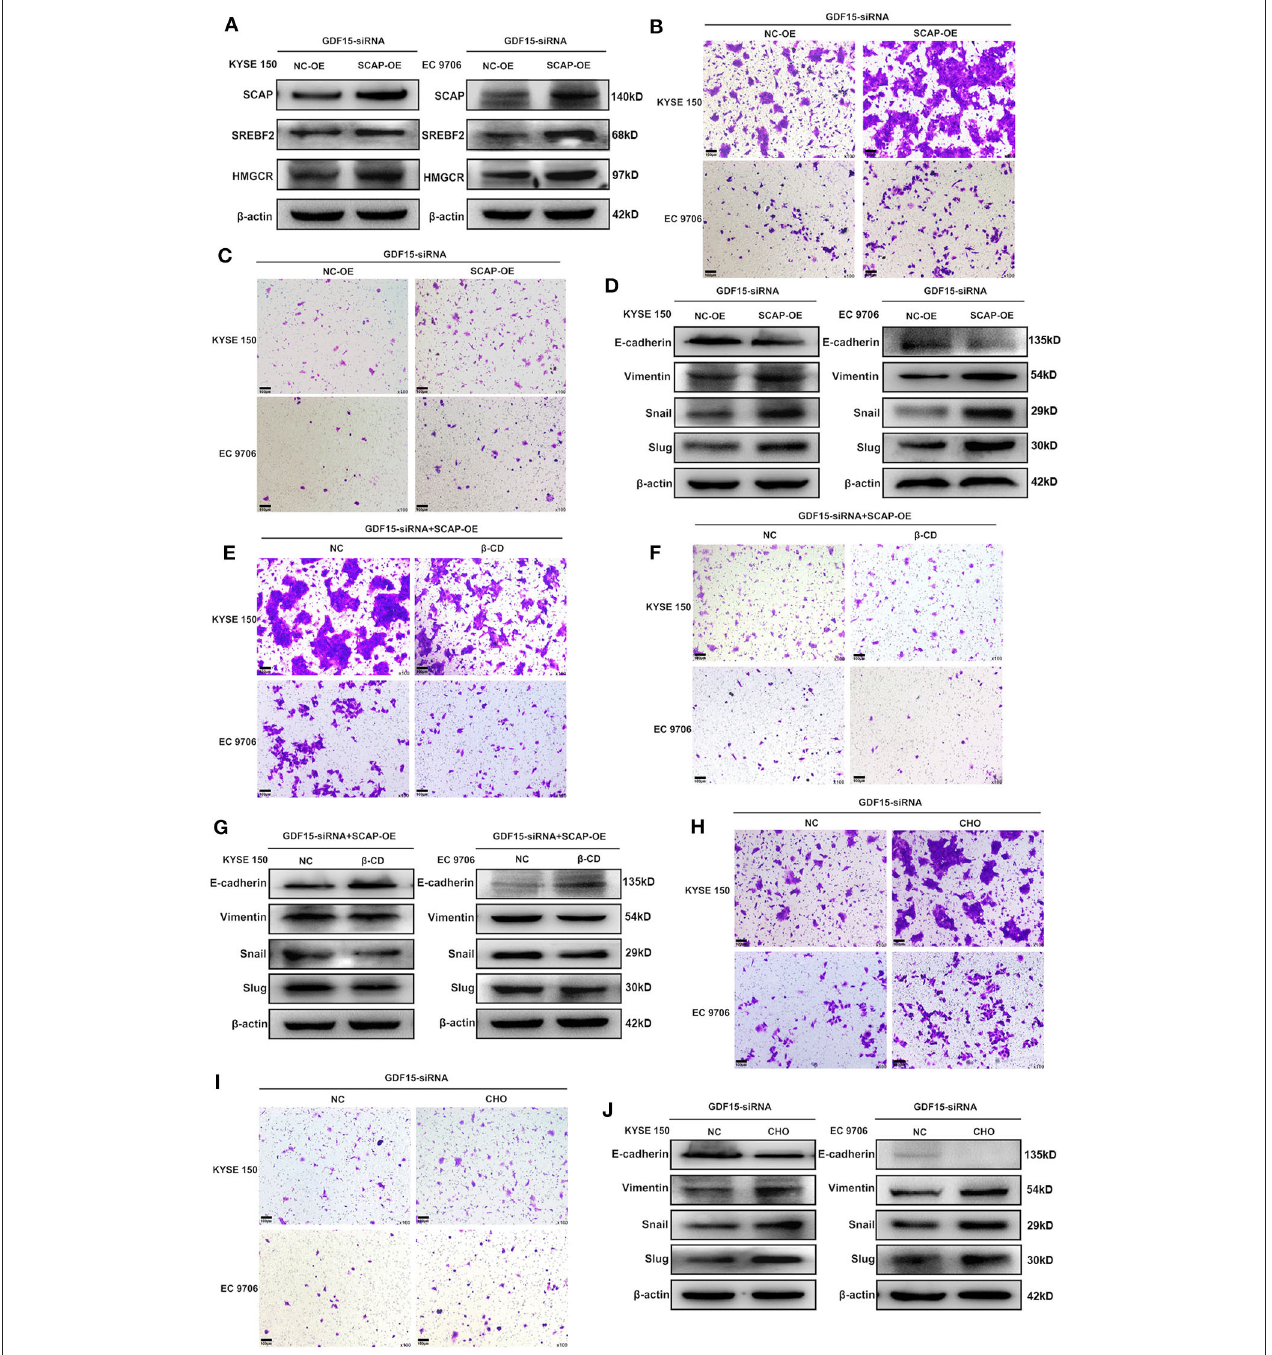
FIGURE 4 | SCAP mediated GDF15-induced migration and invasion of ESCCs via cholesterol metabolism. (A) Expression levels of SREBF2 and HMGCR in SCAP-overexpressing GDF15-siRNA ESCCs determined by western blotting. (B–G) SCAP overexpression in GDF15-siRNA ESCCs induced cell migration, invasion, and EMT, which was reduced by β -CD treatment (2.5mM). (H–J) Pretreatment with cholesterol (5 ug/ml) induced cell migration, invasion, and EMT of GDF15-siRNA ESCCs.